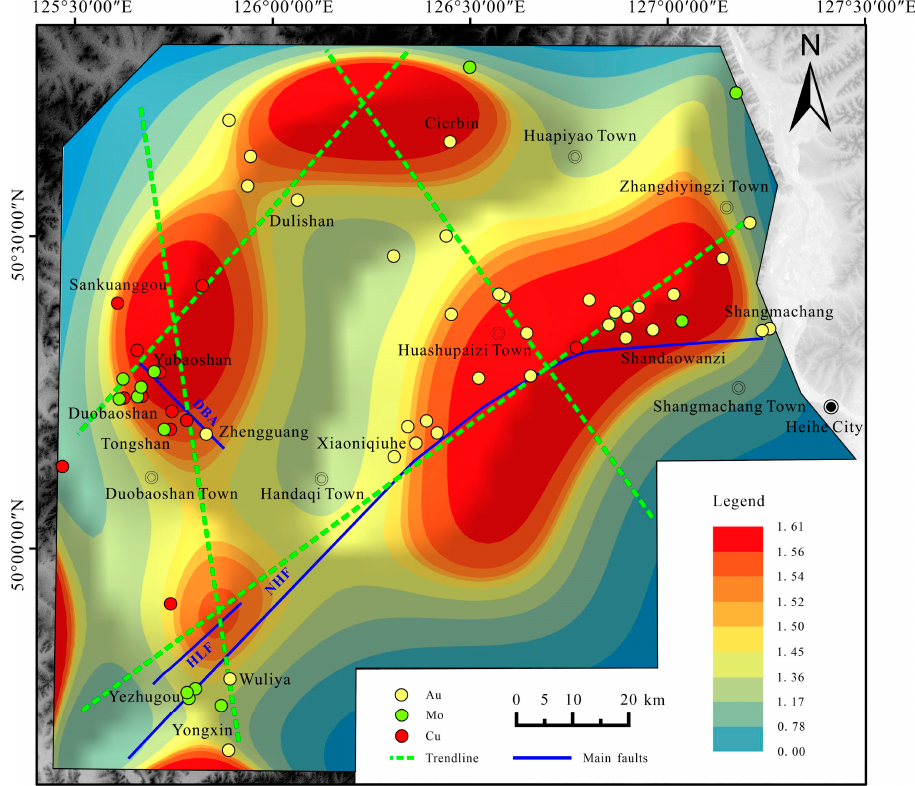
Figure 8. Ten-step tendency map of the fractal dimensions of the lineaments in the study area.